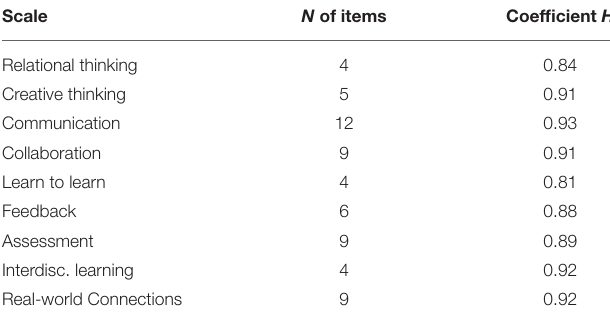
TABLE 7 | Latent reliability of model